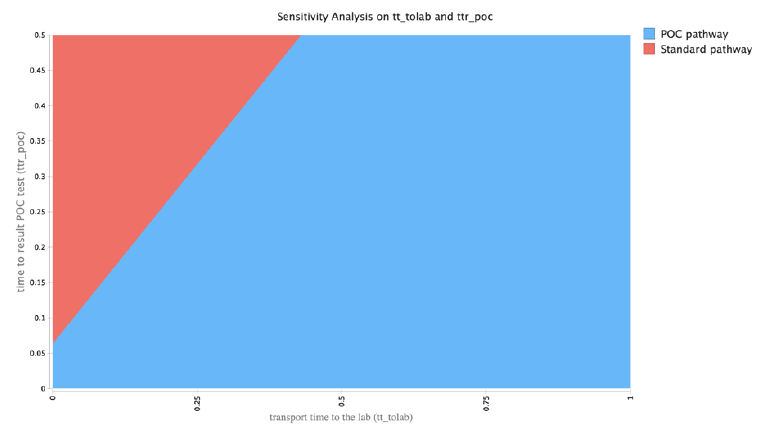
Figure 2. Two-way sensitivity analysis on the transport time to the laboratory (days) and the time to POCT result (days). Results presented are per-patient expected values for both testing strategies.